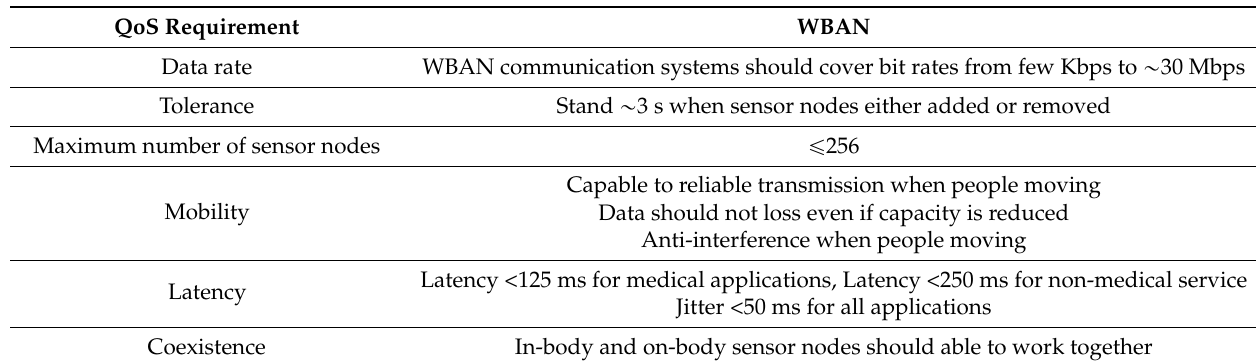
Table 11. The QoS Requirement of WBAN Applications